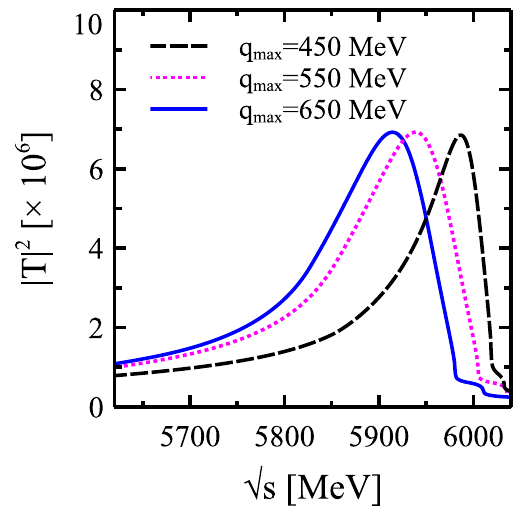
Fig. 2 Modulus squared of the three-body T -matrix as a function √ s for J P = 0 − , 1 − , 2 − . The results correspond to a value of of q max = 450 MeV. The vertical line indicates the three-body threshold, i.e., 3 M D ∗ Table 1 Mass, M , and width, Γ , of the states found in the D ∗ D ∗ D ∗ system with isospin 1 / 2 and spin-parity J P = 0 − for different values of q max M ( Γ ) [MeV]